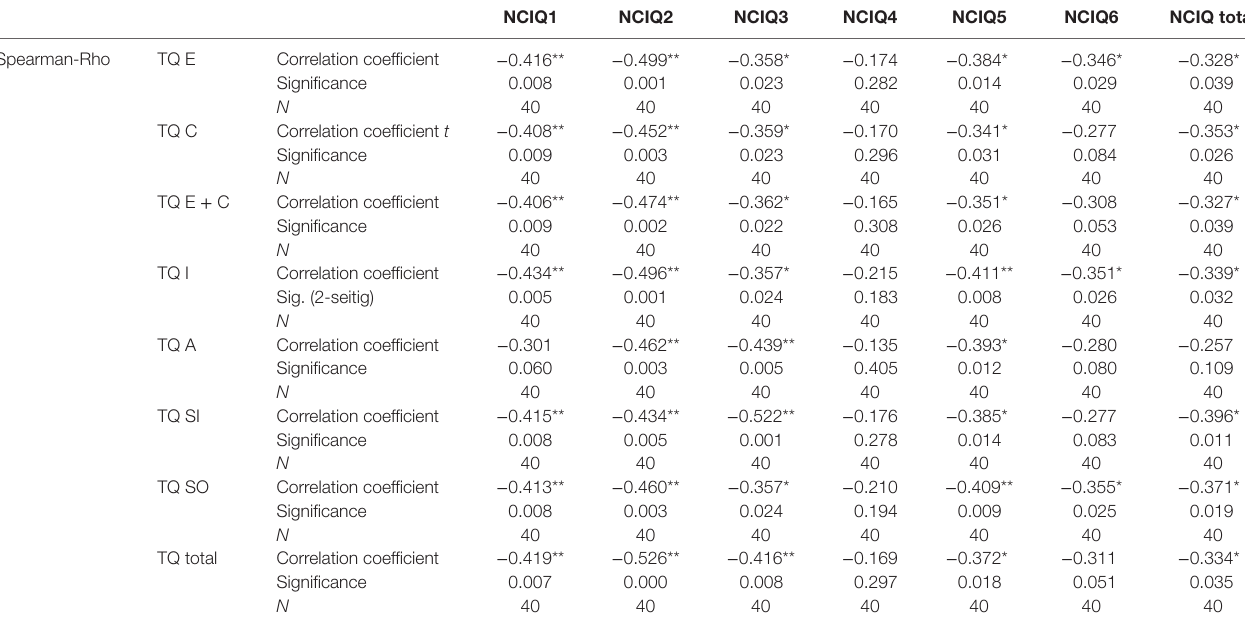
TaBle 7 | correlation between tinnitus and health-related quality of life 24 months after cochlear implantation.